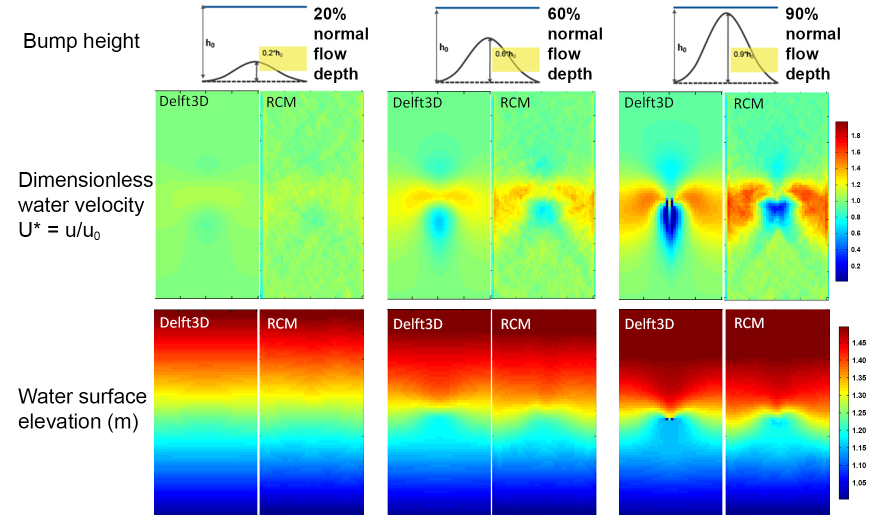
Figure 5. Contour plots of water velocity magnitude (scaled by the normal flow velocity u 0 = 0.5ms − 1 ) and water surface elevation for three cases (bump heights at 20, 60 and 90% of normal flow depth). Flow direction is from top to bottom. Notice the deformation of the water surface and the development of a low velocity region in front of and behind the bump.